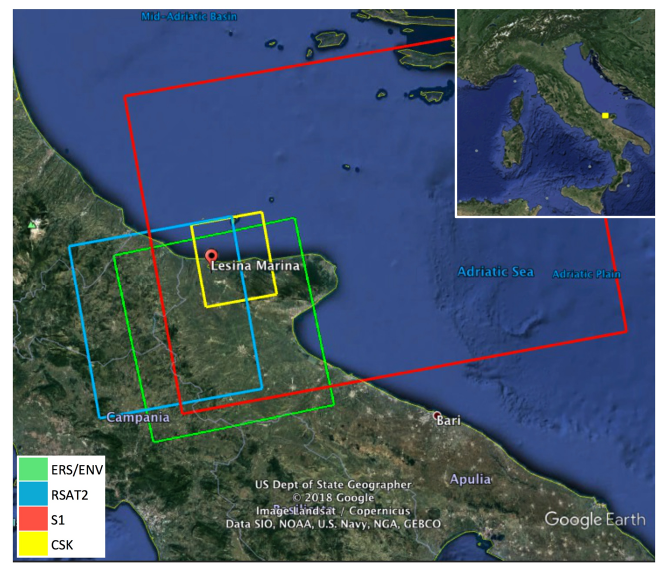
Figure 2. Ground coverage of the SAR datasets used for the MTI processing over Lesina Marina.